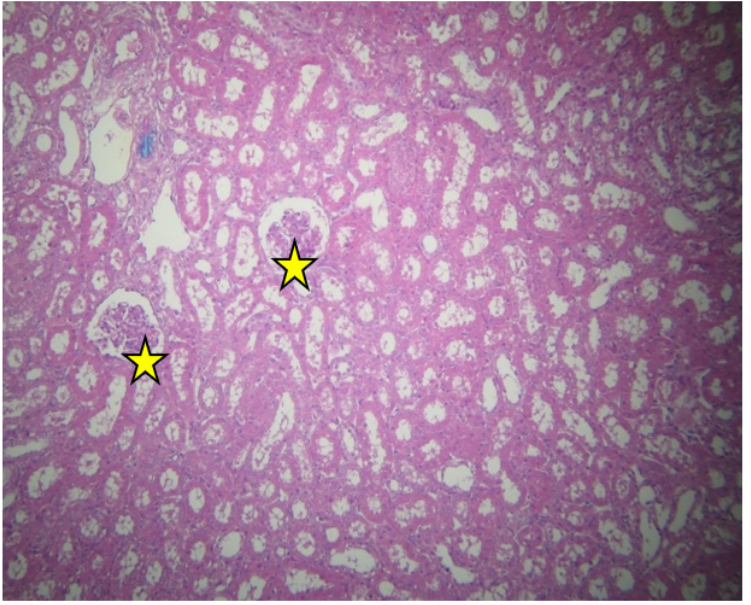
Figure 3. Cortex of resuscitated swine stained with HE. Normal renal corpuscles (yellow stars). Expanded connective tissue in few places, ×40.